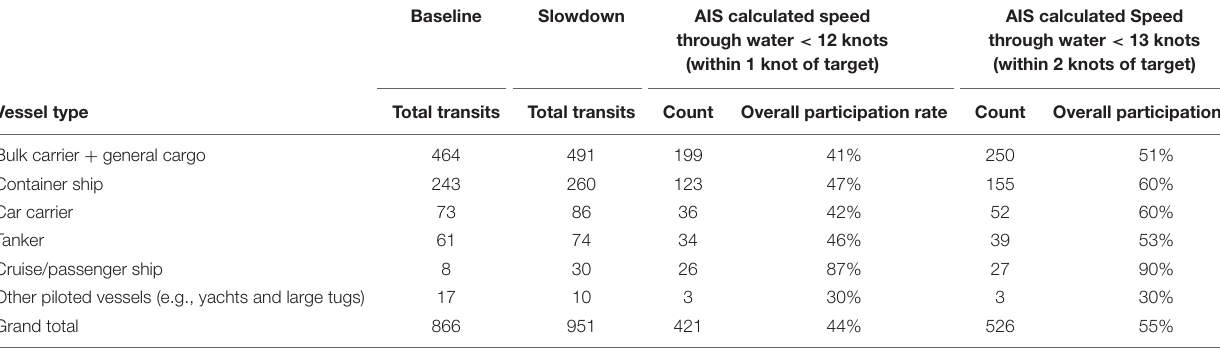
TABLE 4 | Baseline transits, and slowdown participation counts and rates of participation by vessel